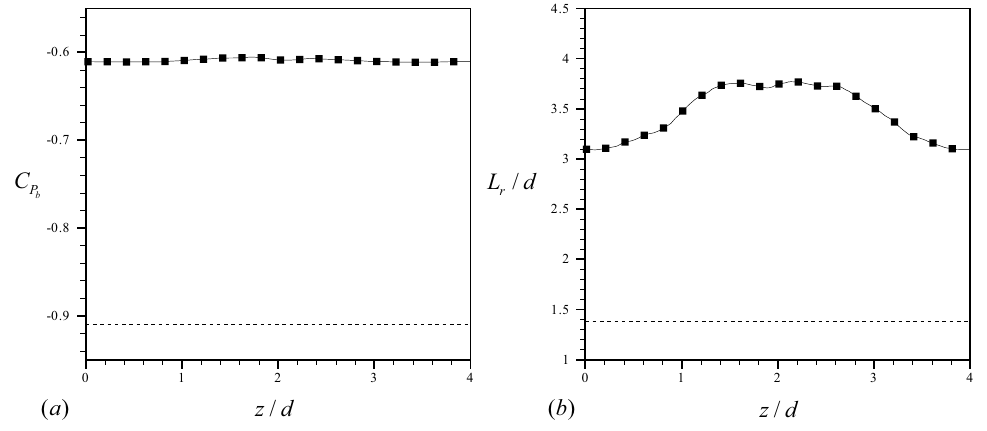
Figure 12. Spanwise variations of the mean base pressure coefficient ( C P in the wake ( L r ): ( a ) C P ; ( b ) L r / d . Dashed line, cylinder without a tab; – (cid:4) – cylinder with tabs of b l y / d = 0.2 and l z / d =